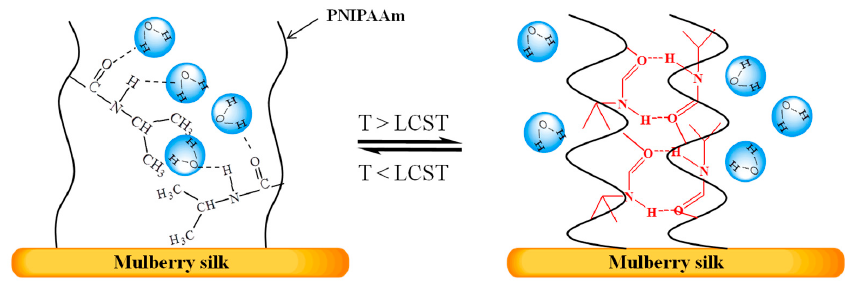
Figure 3. Schematic illustration of the hydrophilic–hydrophobic phase transition.